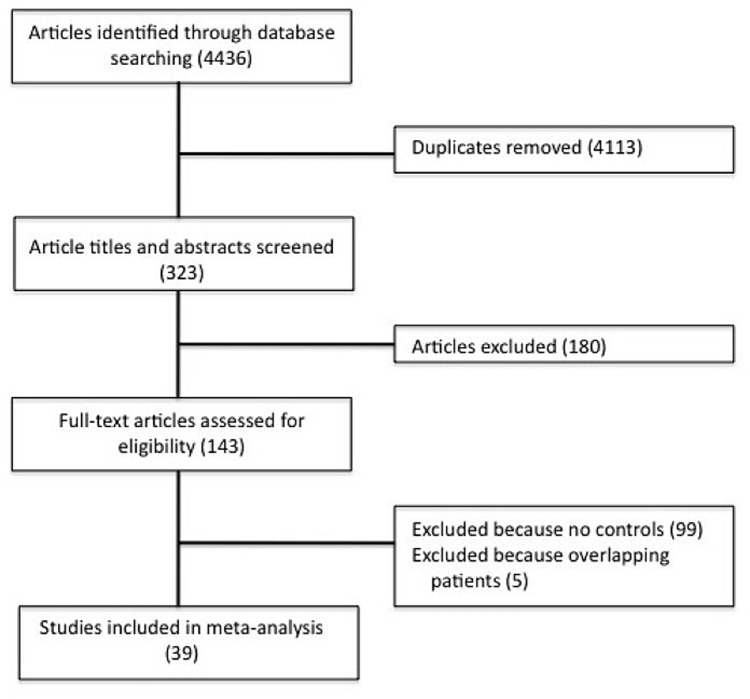
Flow chart of study selection.